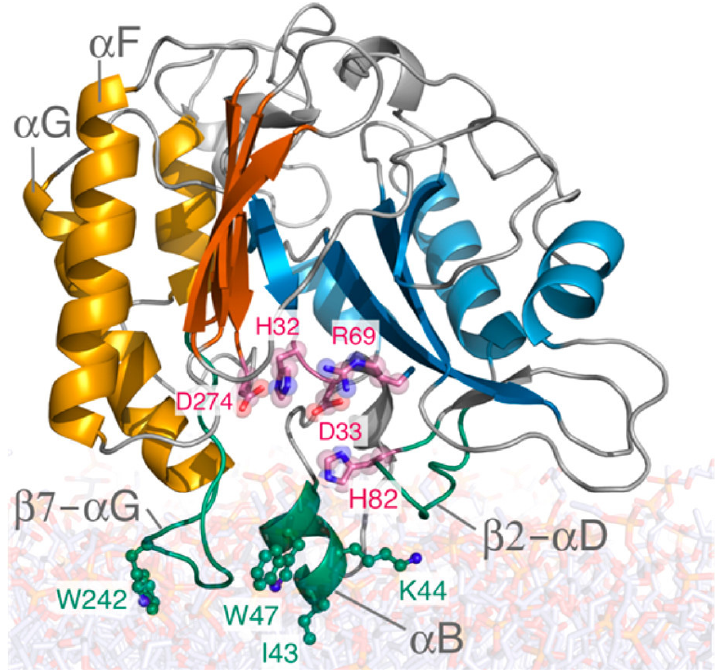
Figure 2. Snapshot of the structure and lipid binding of B. thuringiensis PI-PLC from all-atom molecular dynamics (MD) simulations [13]. The X-box and variable region of the βα barrel are in shades of blue and orange, respectively. The active site is shown as pink sticks for key catalytic residues (His32, Asp33, Arg69, His82, and Asp274); the IBS is green and includes hydrophobic Ile43, Trp47, Trp242, and cationic Lys44. Reprinted with permission from Roberts et al. (2018) Chem. Rev. 2018, 118, 8435–8473. Copyright (2018) American Chemical Society.